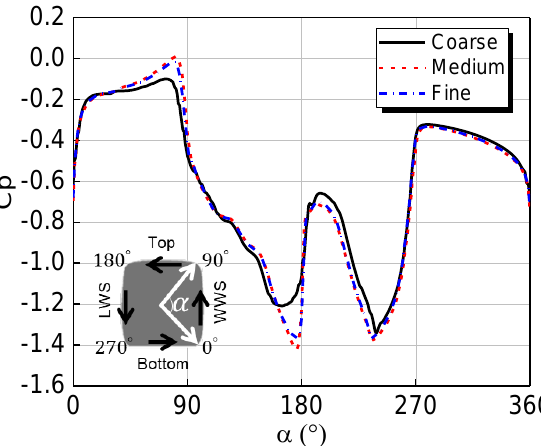
Figure 6. Comparison of different mesh resolutions.